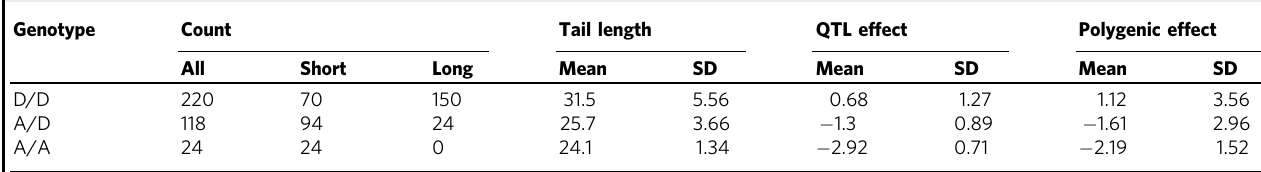
Table 4 The number of individuals, mean and SD of tail length, QTL effects, and polygenic effects of the different genotype